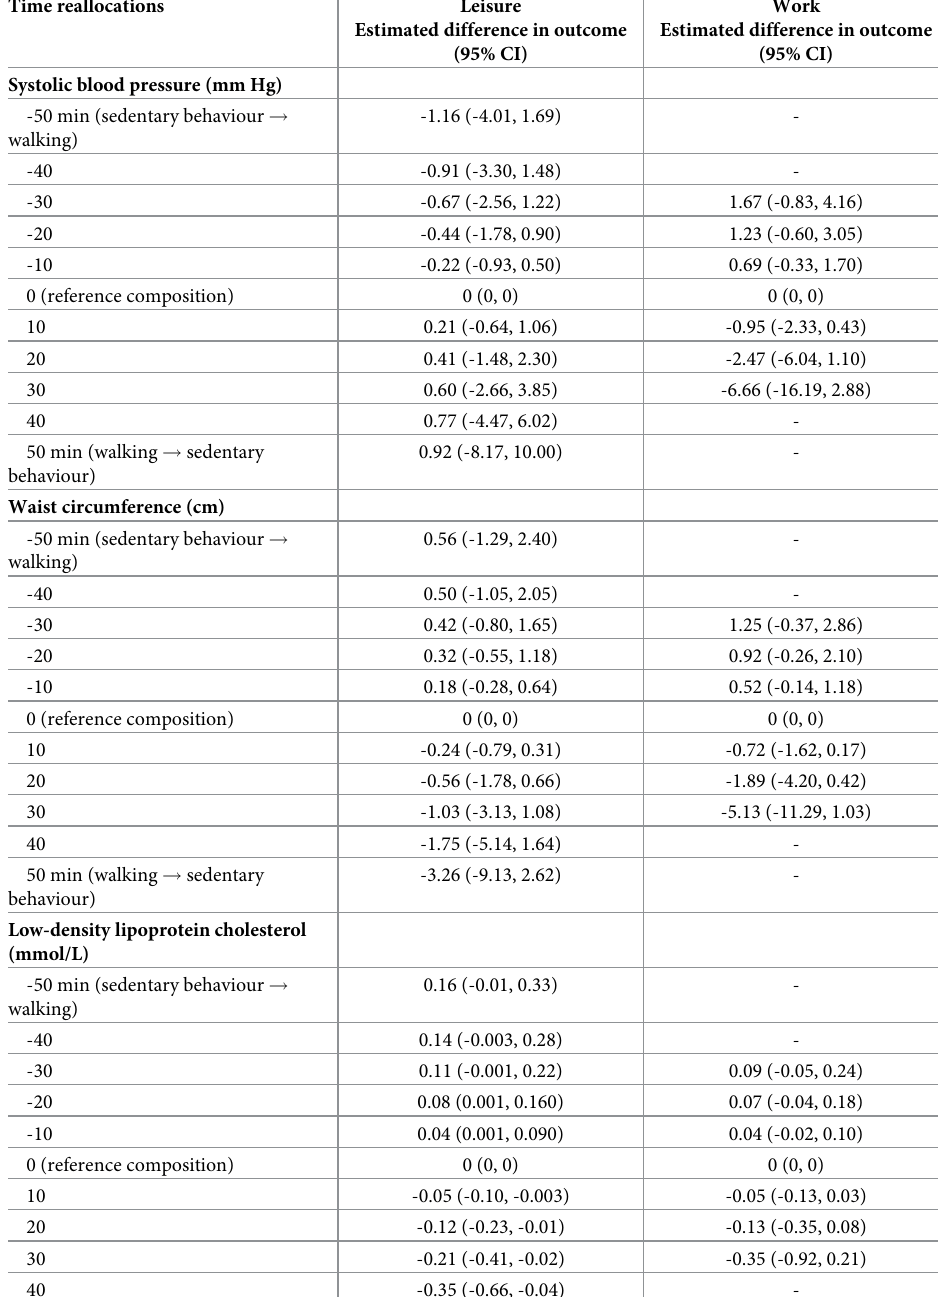
Table 3. Estimated adjusted differences in systolic blood pressure, waist circumference, and low-density lipopro- tein cholesterol given time reallocations between sedentary behaviour and walking during leisure and work among 652 adults in the fifth examination of the Copenhagen City Heart